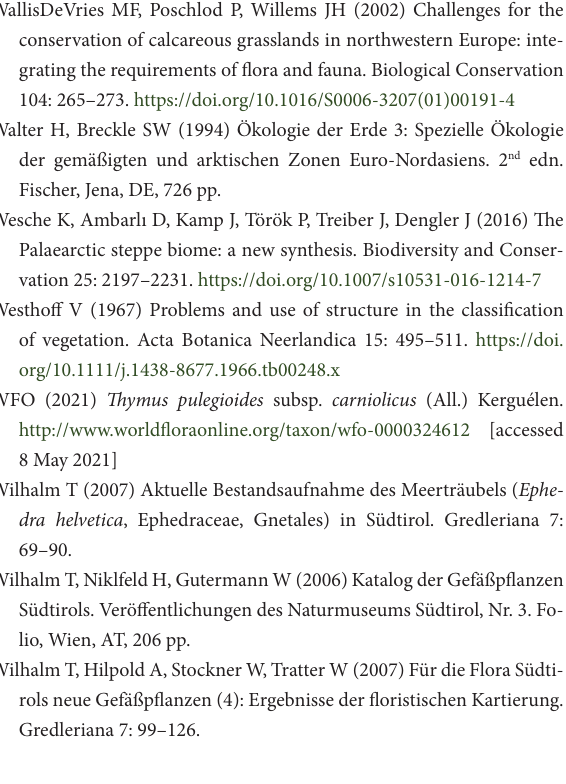
Sorted relevé table of dry grassland communities in the Vinschgau (South Tyrol, Italy) from 2019 (*.xlsx) Link: https://doi.org/10.3897/VCS/2021/65217.suppl1